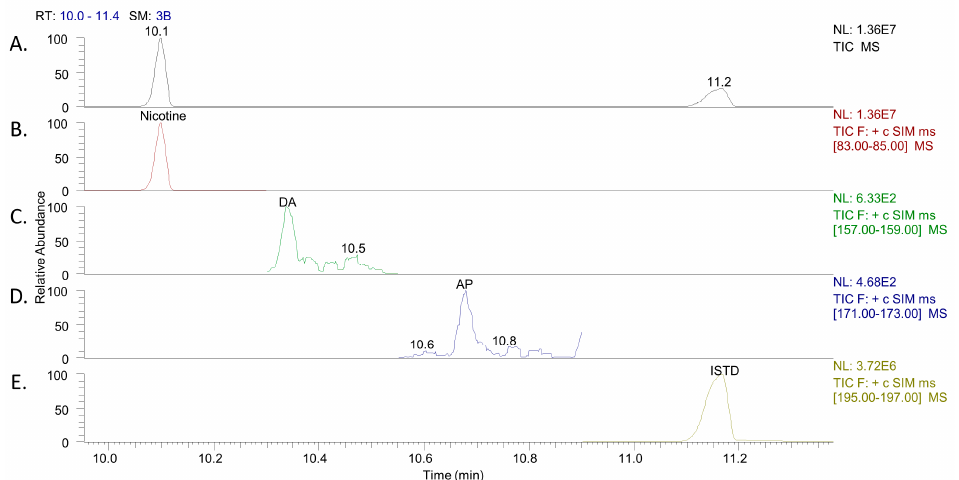
Figure 2. ( A ). Total ion current chromatogram of nicotine, DA, AP, and ISTD using GC-MS. ( B – E ). Extracted ion chromatograms of nicotine ( m/z 84), 5 μ g/mL DA ( m/z 158), 5 μ g/mL AP ( m/z 172), and ISTD ( m/z 196).